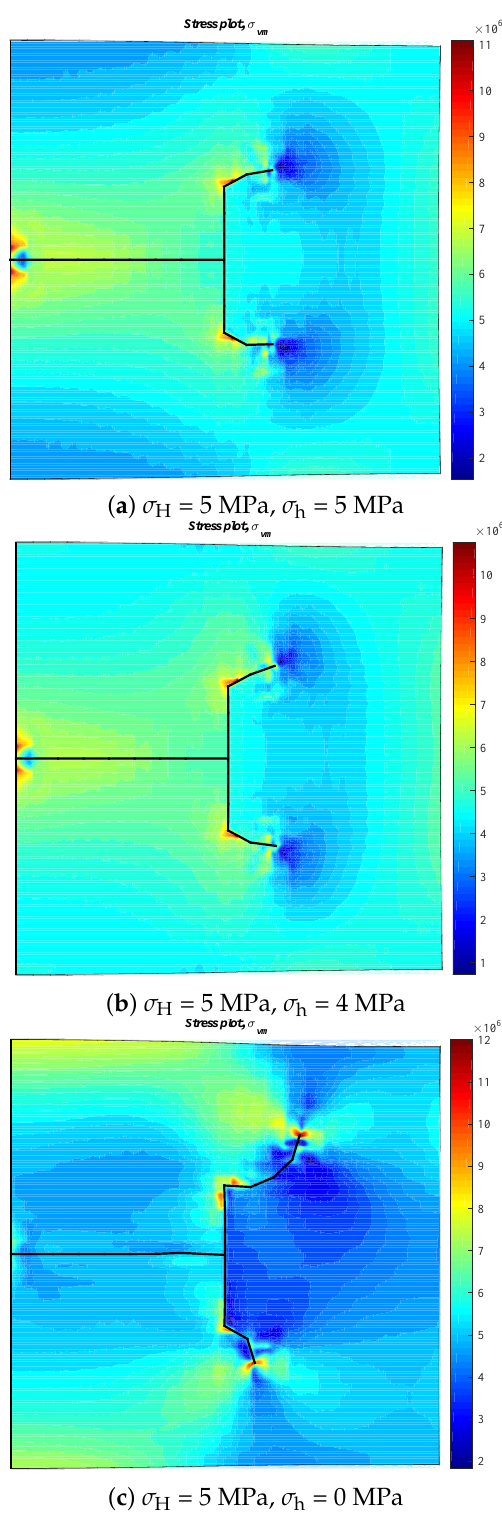
Figure 11. Von-Mises stress distributions at different levels of remote horizontal principle stress